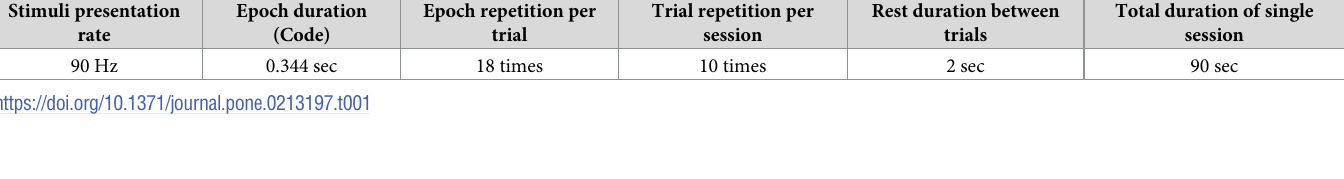
Table 1. The stimuli specifications for both m-sequence and chaotic codes. Stimuli presentation